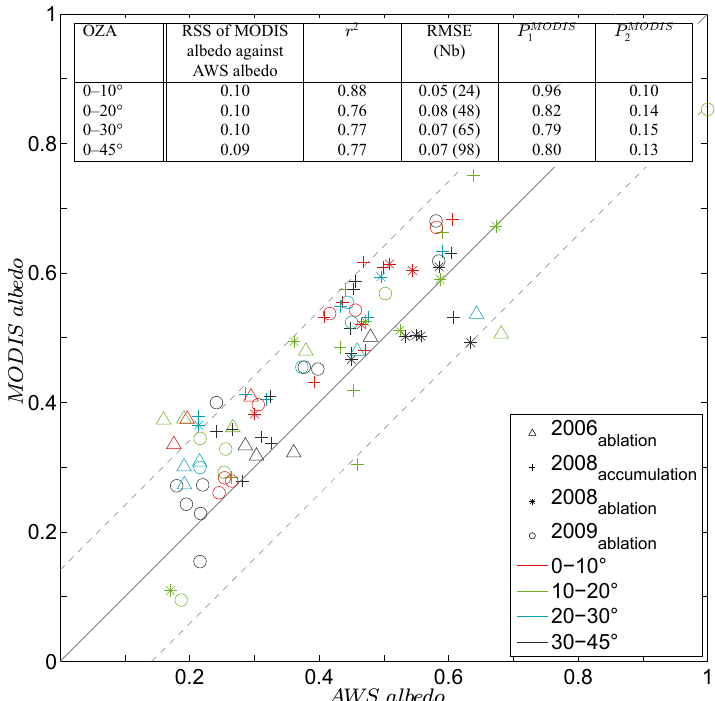
Figure 3. MODIS albedo and AWS albedo data for different OZA classes on Saint-Sorlin Glacier. Years indicated in the caption cor- respond to the year of acquisition while subscripts express the AWS location in the accumulation or ablation areas. The mean discrep- ancy between MODIS and AWS albedo per OZA is quantified by the RSS (residual sum of square). Correlation coefficient per OZA classes are also provided, with r 2 , RMSE together with the number of compared measurements (Nb), and coefficients of the equation: MODIS albedo = P MODIS AWS albedo + P MODIS . The continuous grey line illustrates the 1 : 1 relationship between AWS and MODIS re- 1 2 trieved albedo. Thin and dotted lines represent the combined uncertainties on both AWS- and MODIS-retrieved albedo (absolute value of 10% for each), only accounting for intrinsic sensor accuracy and not for errors related to the acquisition context, e.g. size of the footprint.